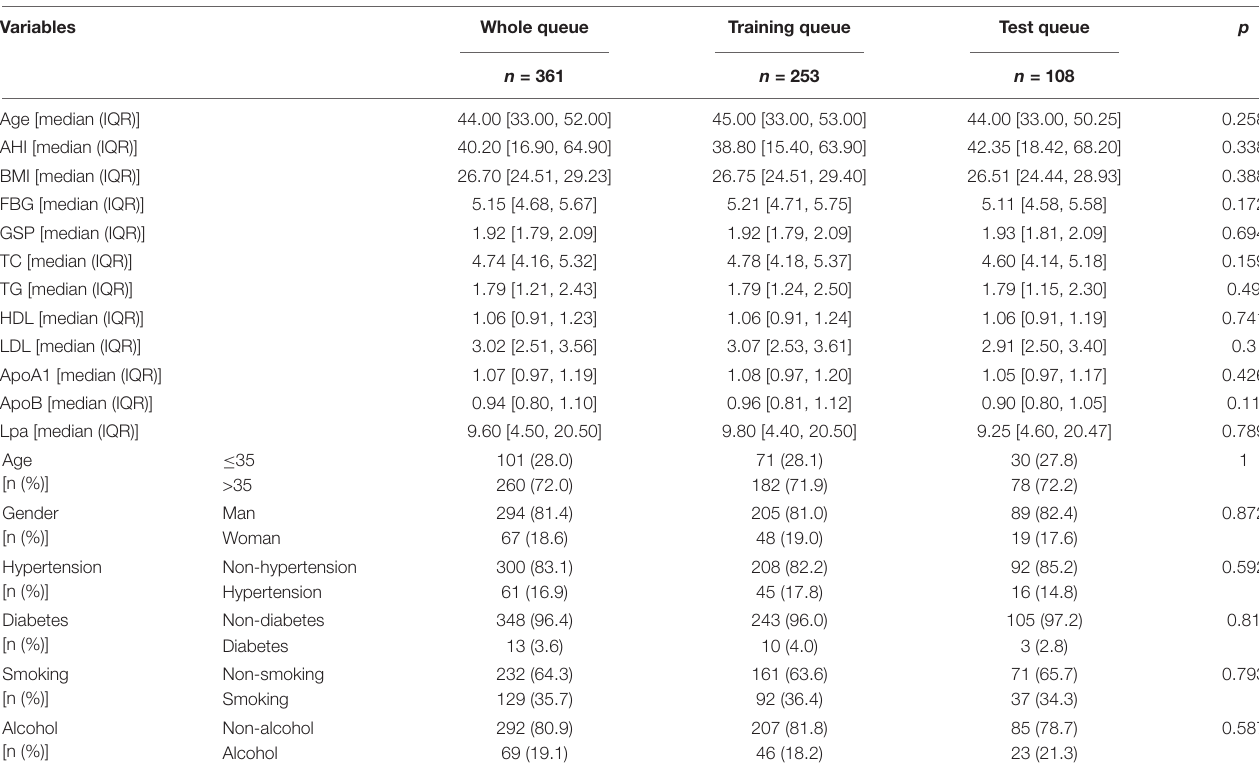
FIGURE 6 | Comparison of the prediction performance of MFN, BAFN and BLFN. (A) Calibration curves of mixed results. The x-axis and y-axis represent the risk predicted by the nomogram and the risk diagnosed. The diagonal dashed line represents the perfect prediction of the ideal model (47). The black, yellow and blue solid lines represent the performance of MFN, BAFN and BLFN, respectively, of which a closer fit to the diagonal dotted line represents a better prediction. (B) ROC curves of mixed results. The X axis and Y axis represent 1-specificity and sensitivity, respectively. The lower right corner of the figure shows the corresponding AUC values of MFN, BAFN and BLFN, and the 95% confidence interval, respectively. (C) DCA curves of mixed results. The y-axis measures the net benefit (47). The thin solid gray line and the thin black solid line represent the assumptions that all patients rely on and do not rely on MFN predictions, respectively. The black, yellow, and blue thick solid lines represent the predictions of MFN, BAFN, and BLFN, respectively. TABLE 3 | Statistics of indicators for three